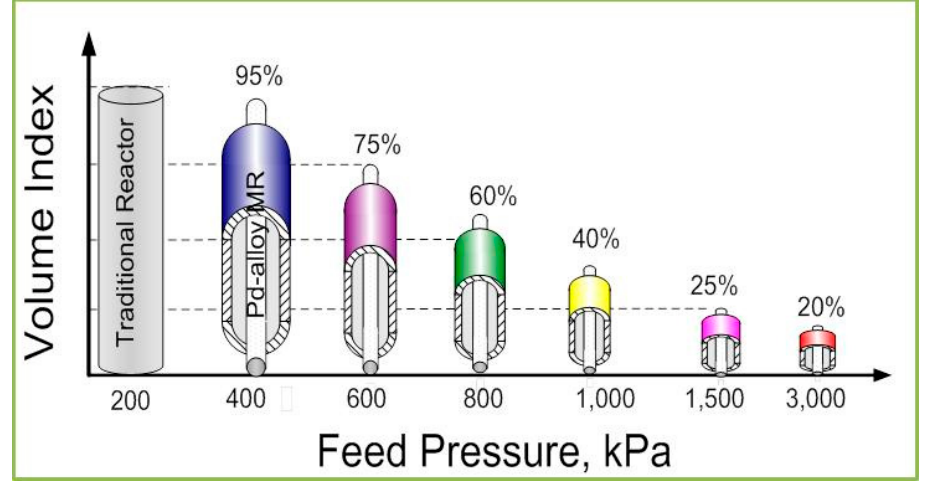
Figure 3. Volume index as a function of the feed pressure at 280 °C. Set CO conversion: 90%. Reproduced from [16] with permission from Elsevier.